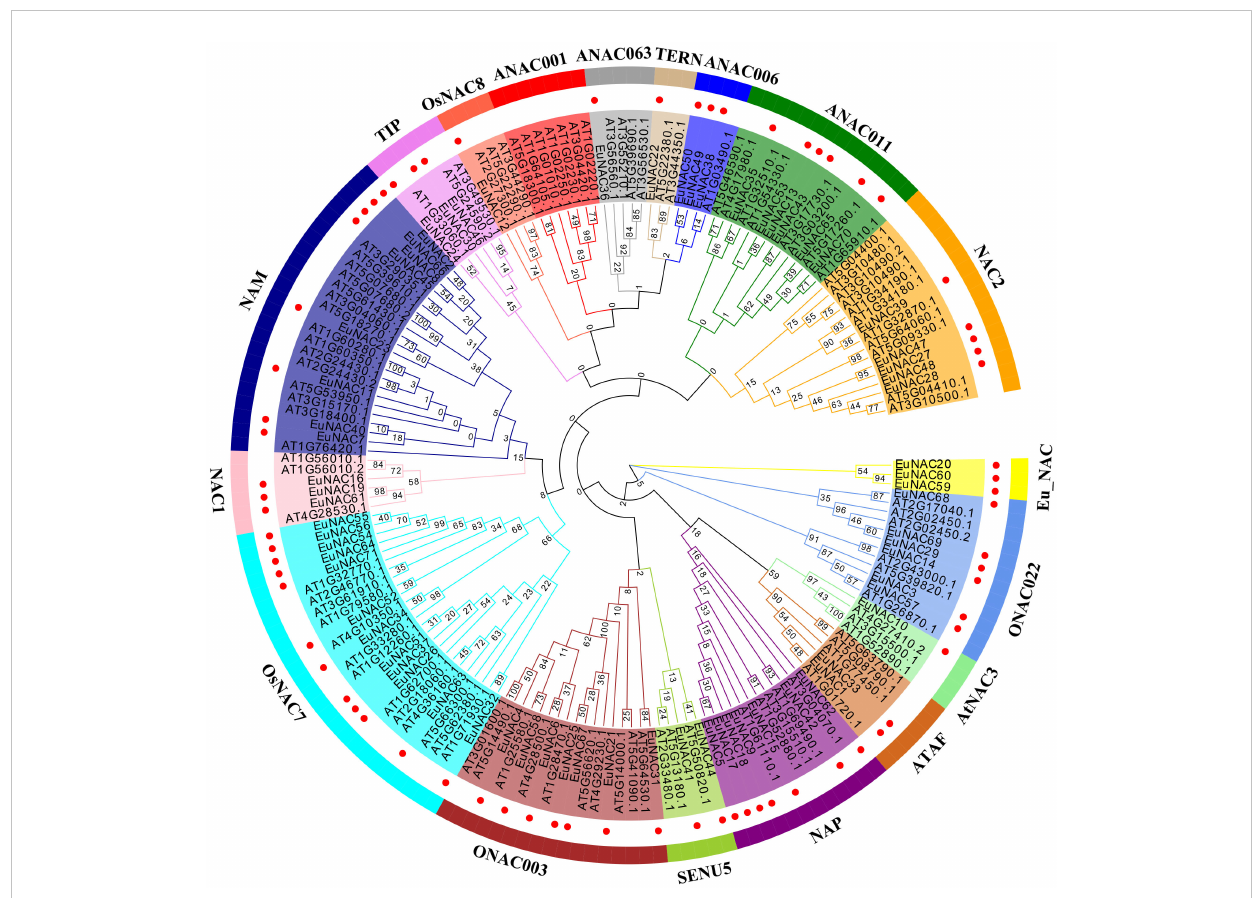
FIGURE 1 Phylogeny of the NAC TFs of Arabidopsis thaliana and Eucommia ulmoides . The tree branched the NAC proteins into different groups illustrated by different colored clusters within the clade. Markers of genes with red circles were EuNAC. The phylogenetic tree was prepared using the neighbor- joining (NJ) method with 1000 bootstrap replicates using MEGA